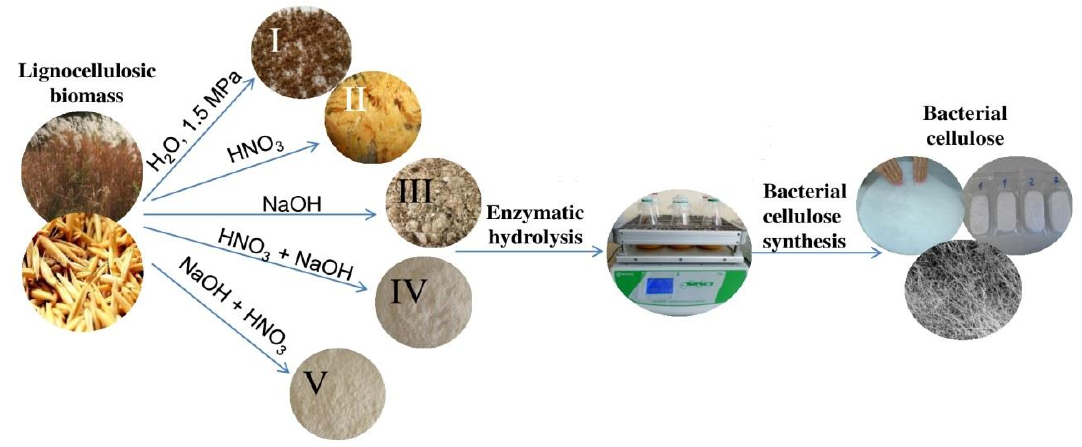
Figure 1. Research flowchart.